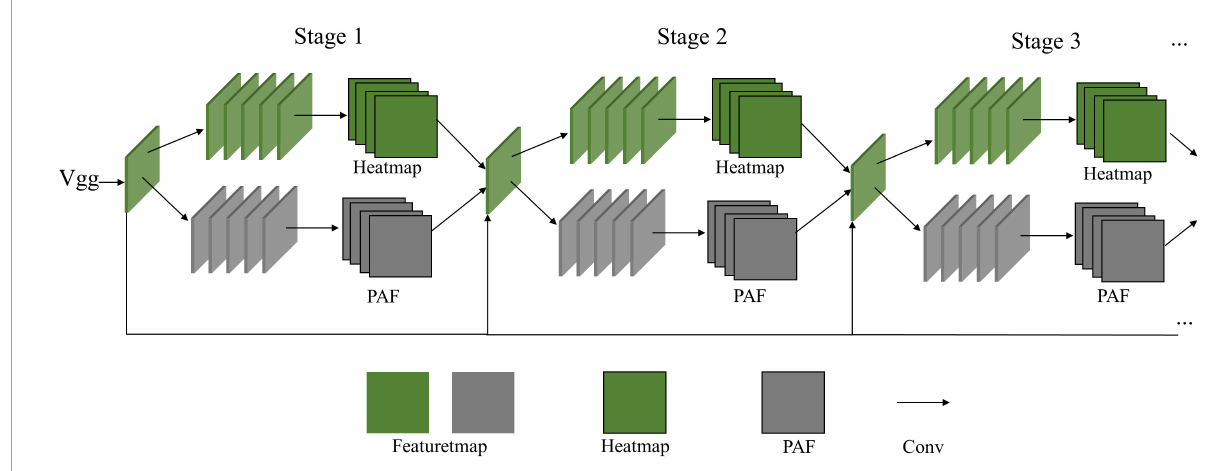
FIGURE1 OP network model with a parallel steam structure of heatmaps and PAFs.